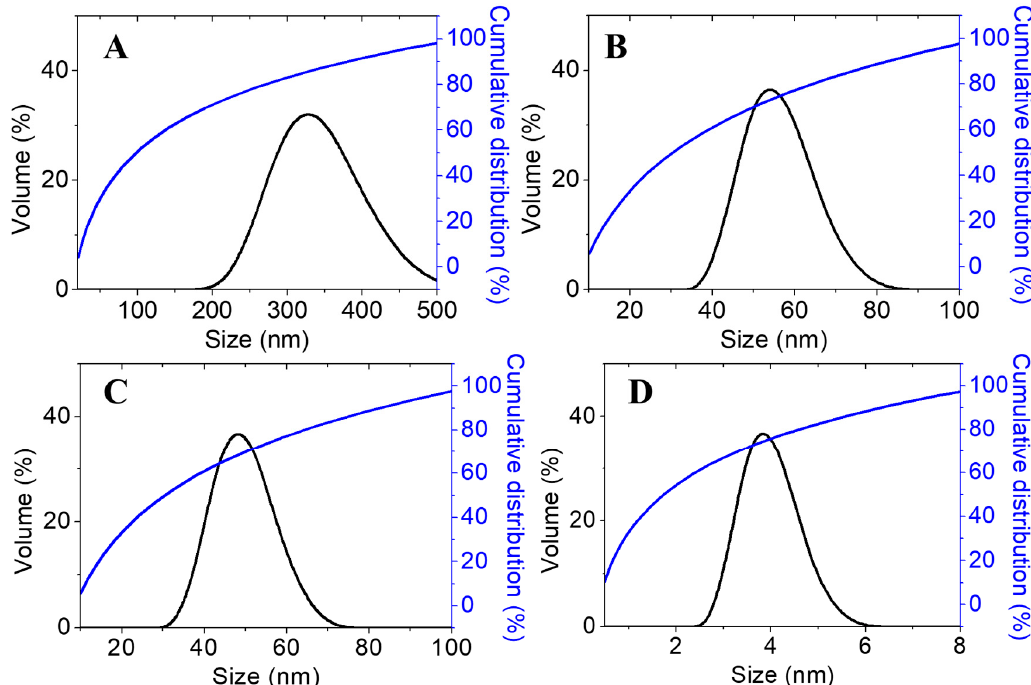
Figure 5. Cumulative and relative particles size distributions (PSDs) of chitosan-dazomet nanoparticles prepared at different concentrations of TPP: ( A ) 2.5, ( B ) 5, ( C ) 10, and ( D ) 20 mg/mL.